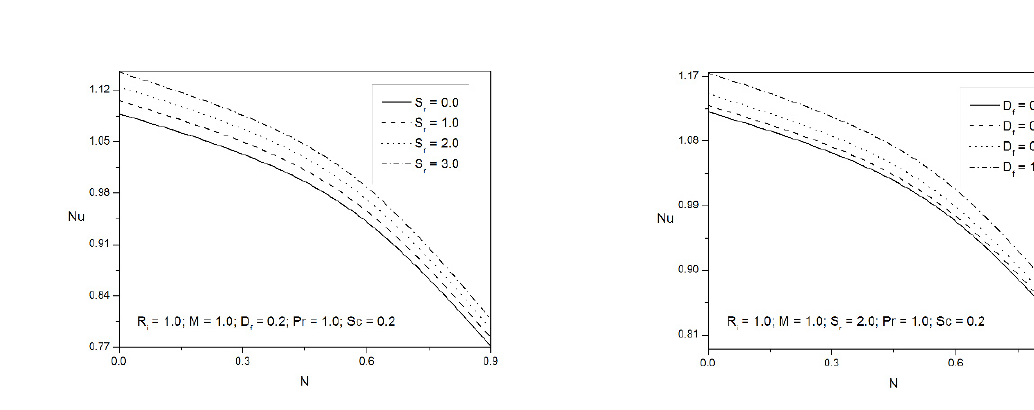
r on Heat Transfer Rate